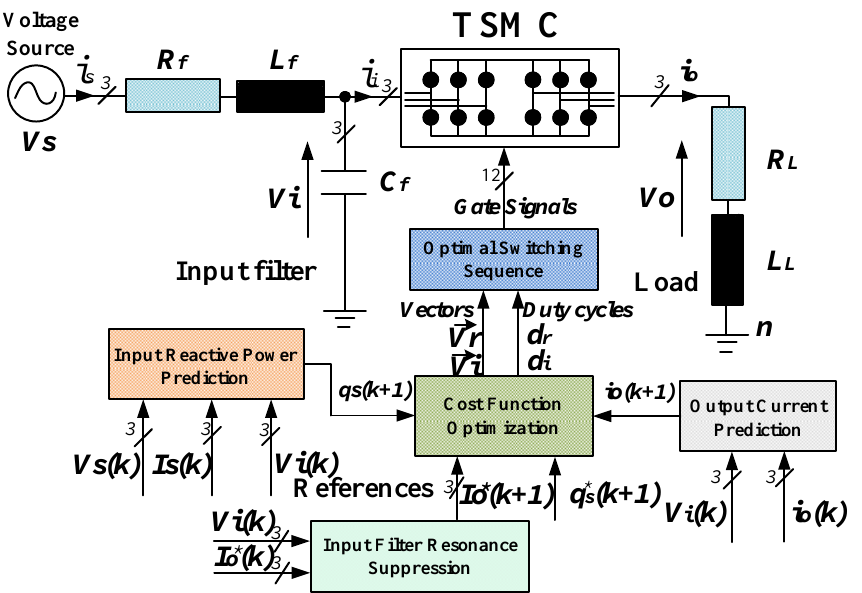
Figure 2. Block diagram of the vector modulation-based model predictive control (VMMPC) with the optimal switching sequence (OSS) and the input filter resonance suppression